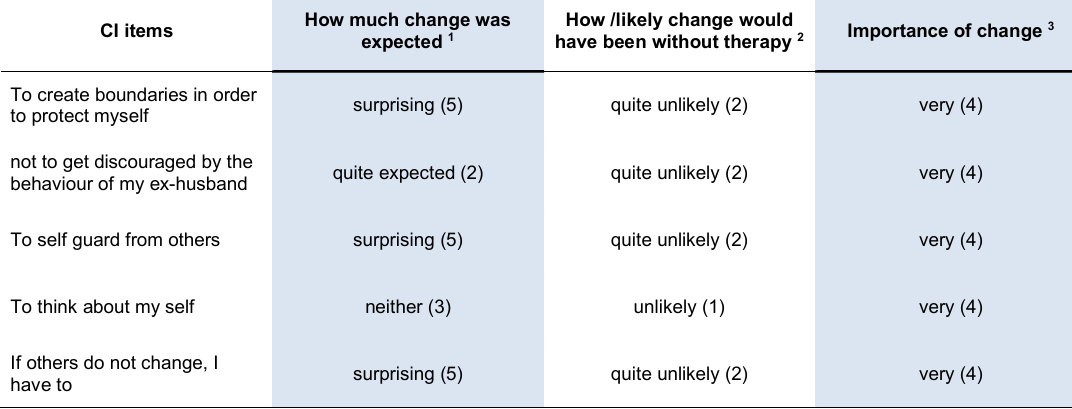
Despite this, at the third follow up all measures once again worsen. The PHQ-9 and the GAD-7 show the worst score ever, the PHQ-9 does not reach the clinical cut off, whereas the GAD-7 reached a score of 11, indicating moderate anxiety. The CORE touches on the clinical cut- off, with a score higher than the pre-therapy level, and the PQ returns to the pre-therapy score. Also the therapist rated the HAM-D with a score of 12 which indicates a relapse into mild depression. Deterioration at the third follow up appears to reflect adverse